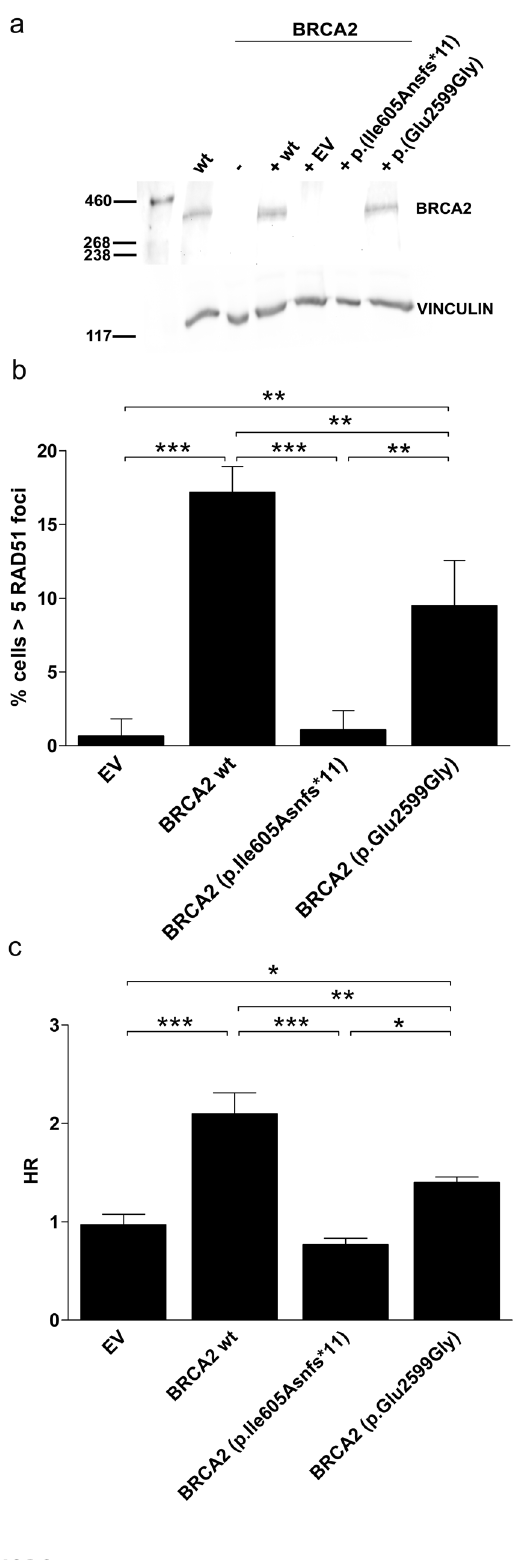
Fig. 4 The hypomorphic missense p.(Glu2599Gly) variant has partial HRR activity. a Only the BRCA2 p.(Glu2599Gly) variant is expressed. Immunoblotting of BRCA2 in wt and BRCA2 KO HEK293T transiently transfected with pCDNA3 wt BRCA2, empty vector (EV), BRCA2 p.(Ile605Asnfs*11) and BRCA2 p.(Glu2599Gly), 48 h after transfection. Vinculin antibody was used as a loading control on the same sample run and processed in parallel. b BRCA2 p.Glu2599Gly variant shows partial complementation of RAD51 foci formation. IR- IF analysis of RAD51 in HEK293T BRCA2 KO cell line expressing wt BRCA2, EV, BRCA2 p.(Ile605Asnfs*11) and BRCA2 p.(Glu2599Gly), 6 h after 5 Gy. Mean of three independent experiments represented. Error bars show s.d. Statistics are done with the One-Way ANOVA test and Bonferroni correction ** P < 0.01, *** P < 0.001. c Intermediate HR ef fi ciency of p .(Glu2599Gly) BRCA2 expressing cells. GFP expression from the DR-GFP reporter was analysed as a measure of HR activity. The percentage of GFP-positive cells for each variant was shown. Results represent the mean of at least four independent experiments. Error bars represent s.d. Statistics are done with the One-Way ANOVA test and Newman – Keuls multiple comparison tests, * P < 0.05, ** P < 0.01, *** P <